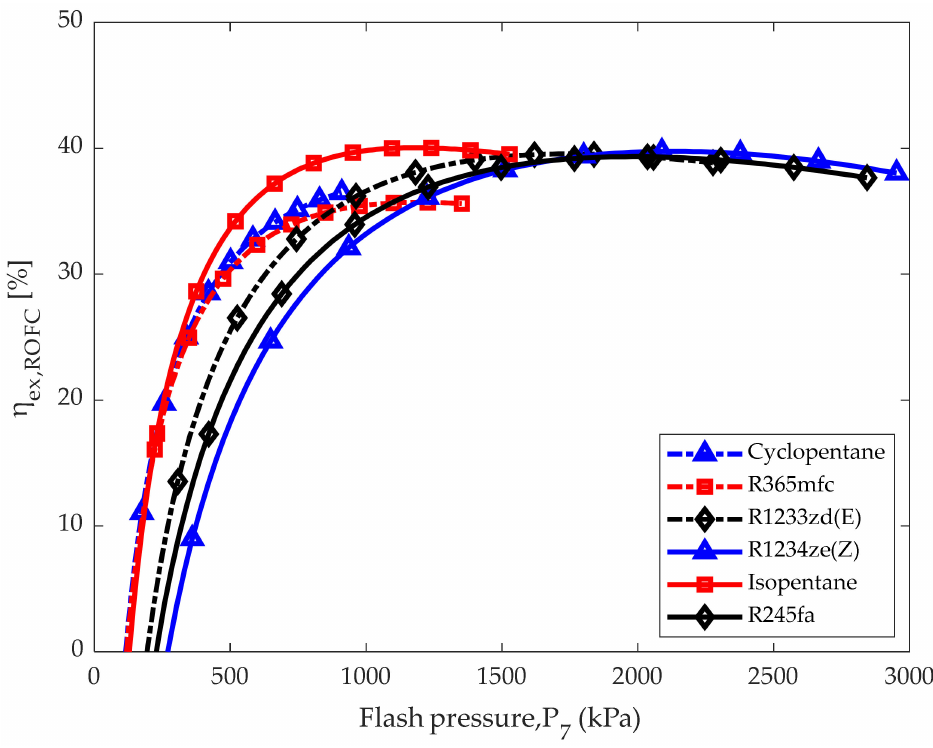
Figure 6. Effect of flash pressure on the exergy